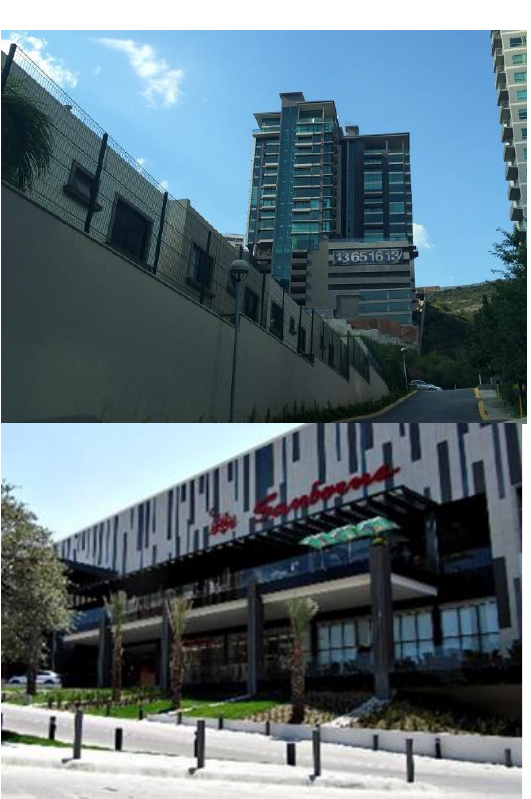
Figure 14 & 15. Global city habitat in Monterrey, Mexico (Gómez,